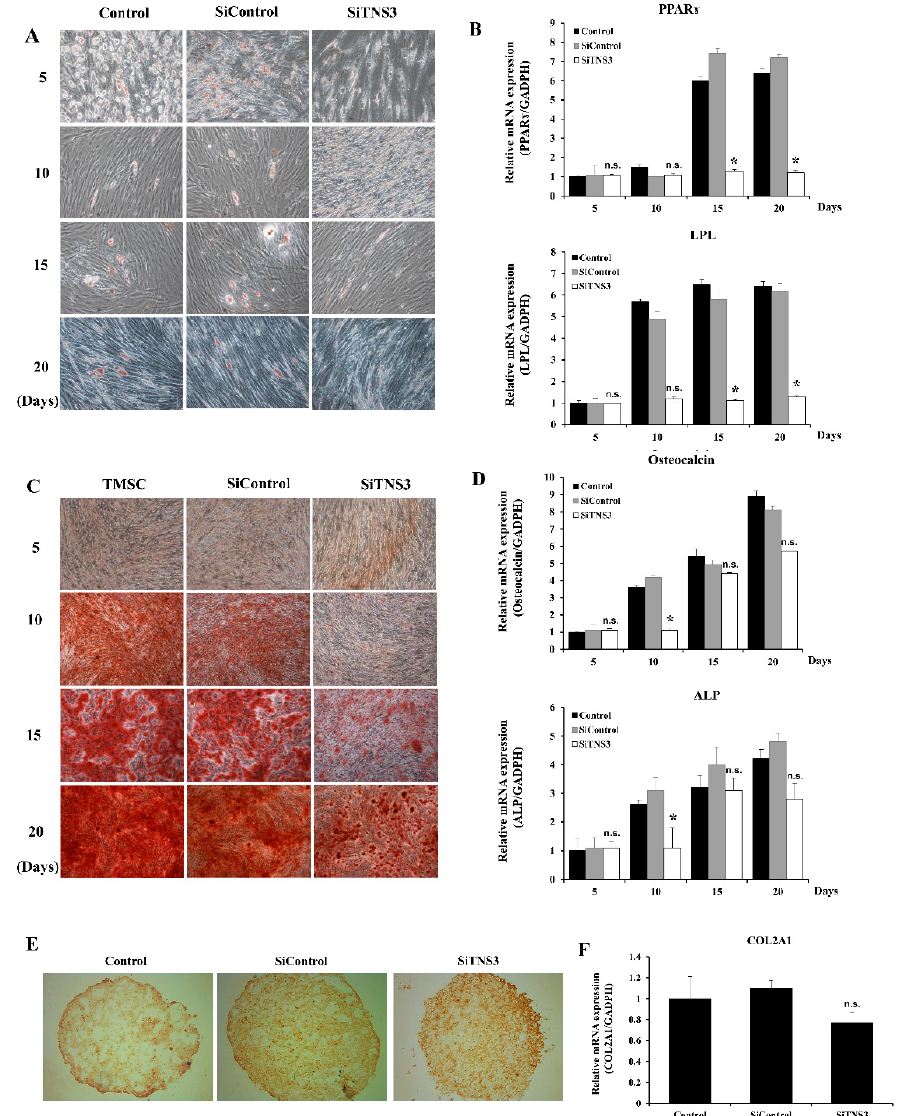
Figure 4. TNS3 plays an important role in the differentiation of TMSCs. ( A , B ) Adipogenic differentiation. Transfection with siTNS3 reduced the number of cells containing lipid droplets during the whole study period in the Oil Red O staining assay ( A ). RT-qPCR revealed that the siTNS3-transfected TMSCs had reduced expression of adipogenic transcripts (PPAR γ and LPL) after induction for 15 and 20 days ( B ). ( C , D ) Osteogenic differentiation. Enhanced Alizarin Red S staining was observed from day 10 in the control group, whereas weak staining was observed even on days 15 and 20 in siTNS3-transfected TMSCs, where the level of calcium deposition was much lower than that in the control ( C ). Treatment with siTNS3 reduced the expression of osteocalcin and ALP in the control on day 10 ( D ). ( E , F ) Chondrogenic differentiation. Collagen type II immunohistochemical staining was slightly reduced in siTNS3-transfected TMSCs compared to in the control group ( E ). COL2A1 expression was lower in siTNS3-transfected TMSCs than in the control group ( F ). *, p < 0.05 compared to the control. n.s., not significant compared to the control. n = 3. Columns and error bars represent the mean ± standard deviation.